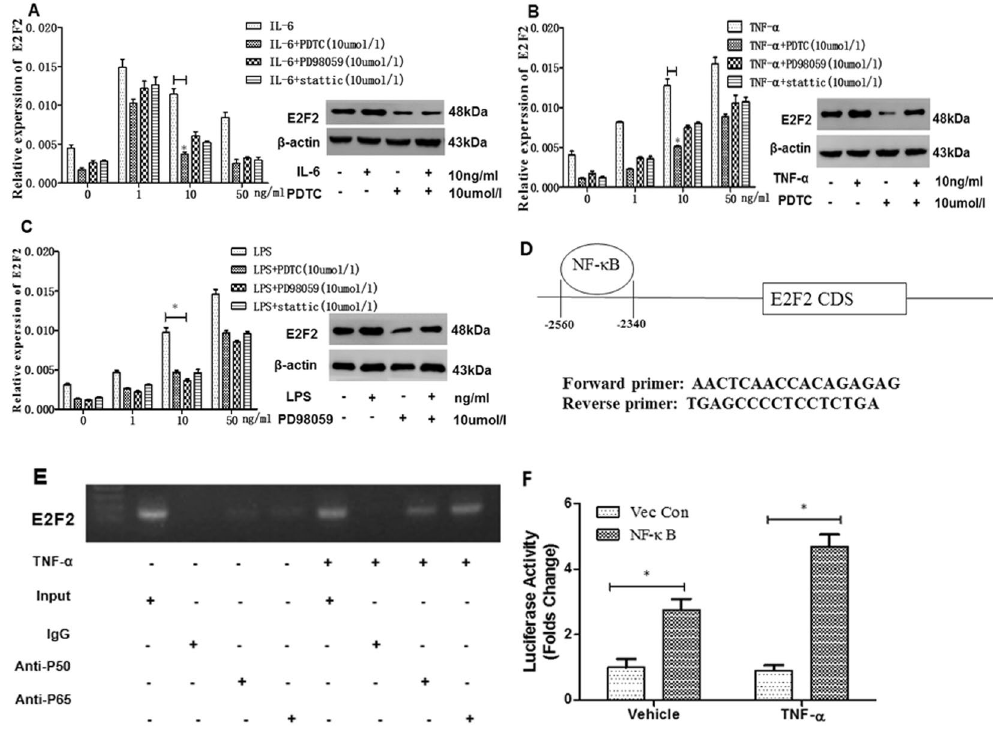
Figure 3. Effects of cytokines on expression of E2F2 and signaling pathways involved in the stimulation. A–C , Effect of signaling pathway inhibitors on cytokines induction of E2F2. RASFs were treated for 2 hours with IL-6( A ), TNF- α ( B ), and LPS( C ) separately, or in combination with pyrrolidine dithiocarbamate (PDTC), PD98059, or Stattic respectively for 24 h. mRNA and protein expression of E2F2 in cell culture were evaluated by RT-qPCR and western blot respectively. ( D ), Schematic representation of E2F2 promoters, primers for the ChIP assay, NF-кB binding motif in E2F2 promoter. ( E ), Binding of the E2F2 gene promoter in RASFs in vitro . ChIP-PCR was used to reveal whether p65 of NF- κ B could bind to the promoter of the E2F2 gene in RASFs in vitro , and the effect of TNF- α stimulation on the binding was assayed using immunoprecipitated chromatin with anti-p65 antibody; (Input, chromatin input before immunoprecipitation; IgG, immunoprecipitated chromatin with control IgG;Anti-p50, immunoprecipitated chromatin with anti-p50 antibody; Anti-p65, immunoprecipitated chromatin with anti-p65 antibody). ( F ), HEK293T cells stimulated with TNF- α , the luciferase reporter activity of NF- κ B was then monitored. The data shown are means ± s.e.m and representation of six independent experiments. * P < 0.05, ** P < 0.01, Values are expressed as mean ± SD of the mean and at least 3 independent experiments were